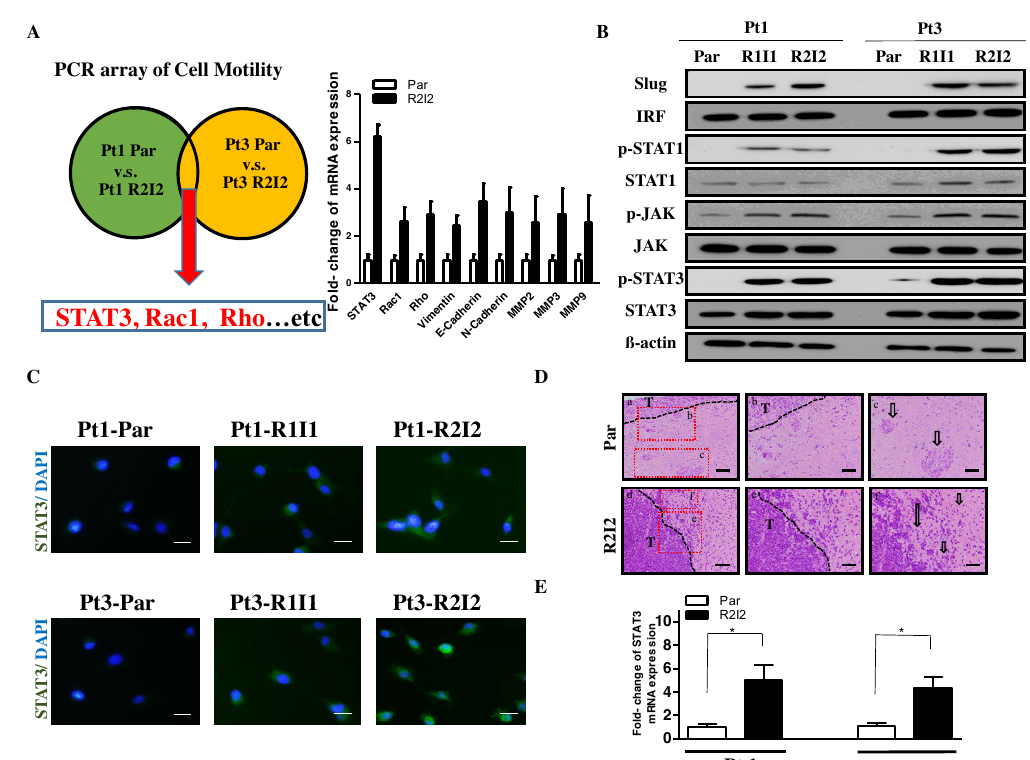
Figure 1. Radioresistant Glioblastoma multiforme (GBM) cells display higher Signal transducer and activator of transcription 3 (STAT3) expression. ( A ) Left panel: Schema for identifying motility-related genes using the Human Cell Motility RT 2 Profiler PCR Array. Right panel: Quantitative Real-Time Reverse Transcription (Q-PCR) analysis of invasion-related genes. ( B ) Western blot analysis showing that STAT3/JAK signaling protein and EMT-associated protein Slug in GBM-Par and GBM-R2I2 cells from two individual patients. ( C ) Immunofluorescence of STAT3 expression in GBM–R2I2 and Par cells. DAPI (4 (cid:48) ,6-diamidino-2-phenylindole) staining identified the nuclei. Scale bars: 20 µ m. Blue: DAPI; Green: STAT3. ( D ) Upper panel: GBM-Par histology showing reduced cell invasive characteristics such as a clear tumor border ( b ) and large mass islands ( c ; arrow) with a stellate appearance. Lower panel: GBM-R2I2 cells have invasive properties such as an indistinct tumor borderline ( e ) and small tumor islands ( f ; arrow), along the white matter tracts with single-cell invasion and invasion as cell clusters. Scale bars: 200 µ m ( a and d ), and 100 µ m ( b , c , e and f ). T: Main tumor mass. ( E ) GBM-R2I2 cells show higher STAT3 expression levels than those isolated from GBM-Par cells of xenograft tumors as determined by Q-PCR analysis. * p < 0.01 by Student’s t -test. The data shown are the mean ± SD of three independent